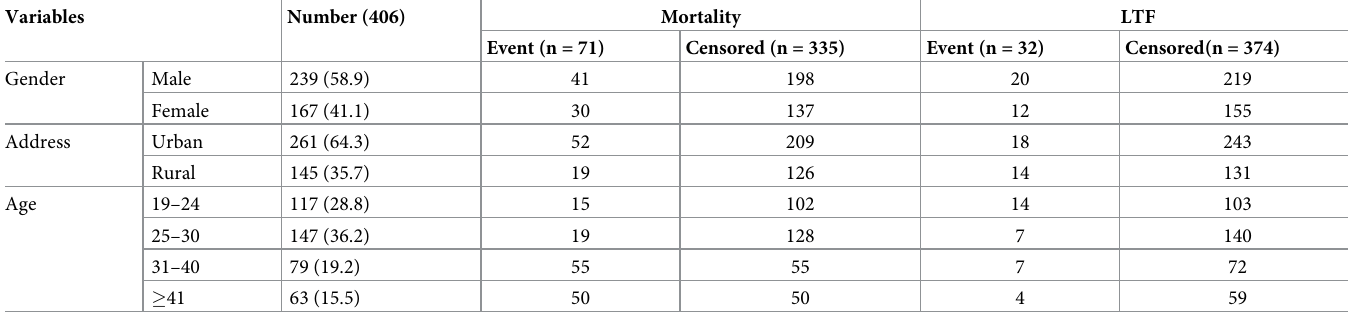
Table 1. Socio-demographic characteristics of drug resistance tuberculosis infected patents in Oromia region, Ethiopia,